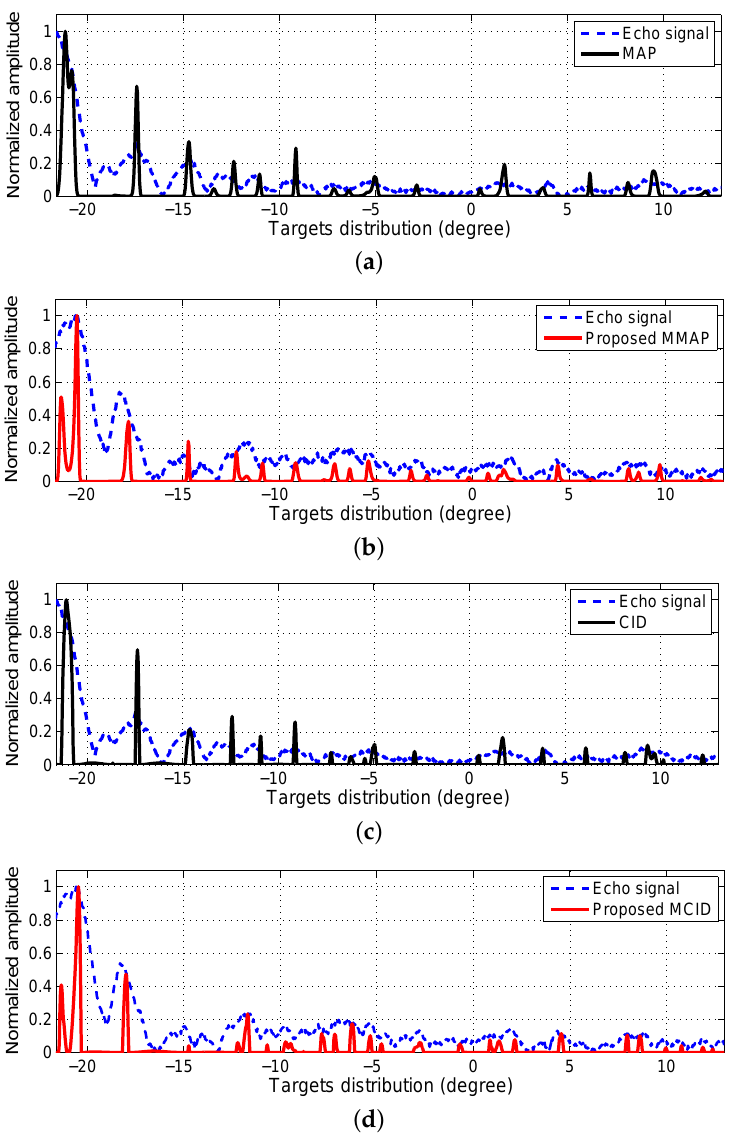
Figure 14. Real radar data of sea surface and coastline in range bin. ( a ) MAP; ( b ) Proposed MMAP; ( c ) CID; ( d ) Proposed